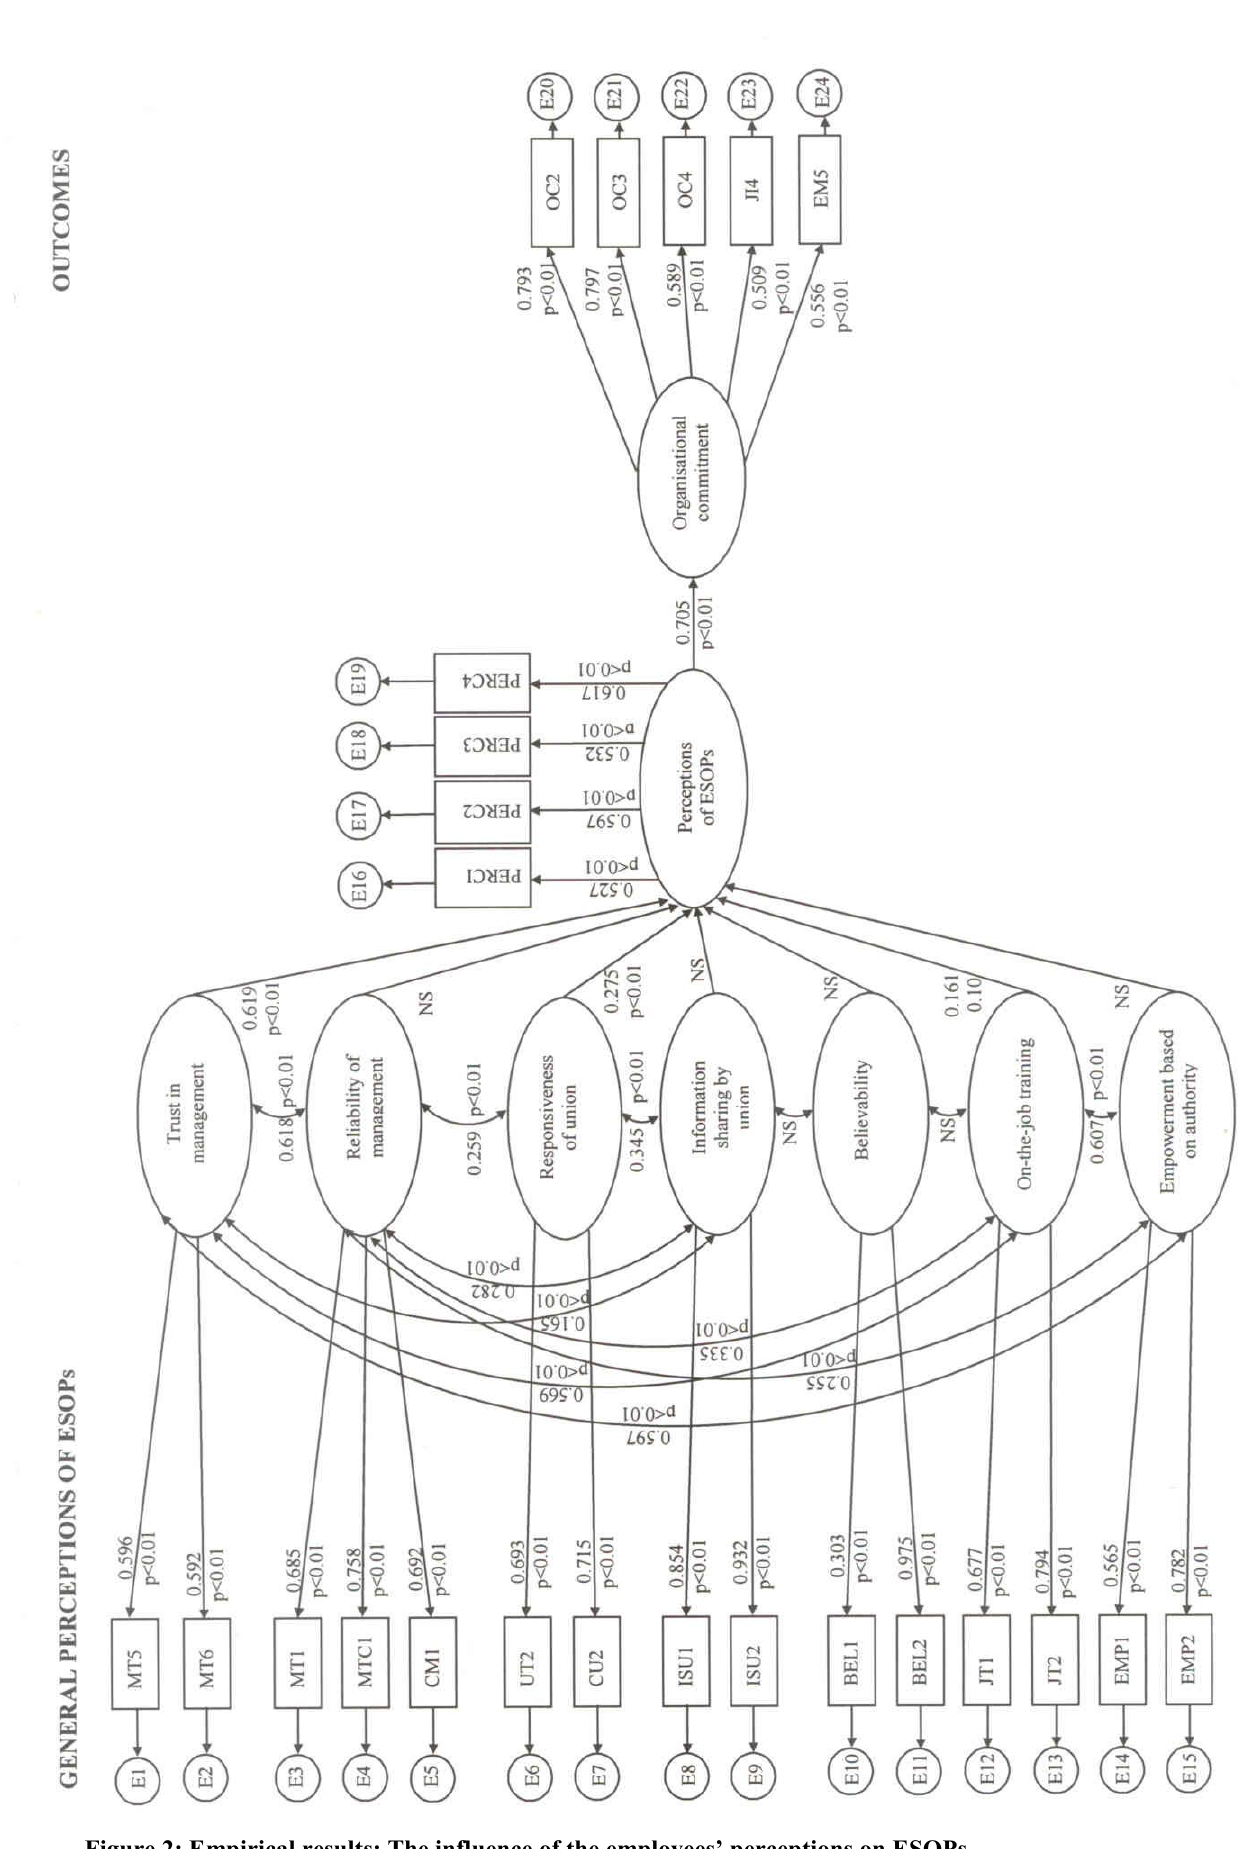
Figure 2: Empirical results: The influence of the employees’ perceptions on